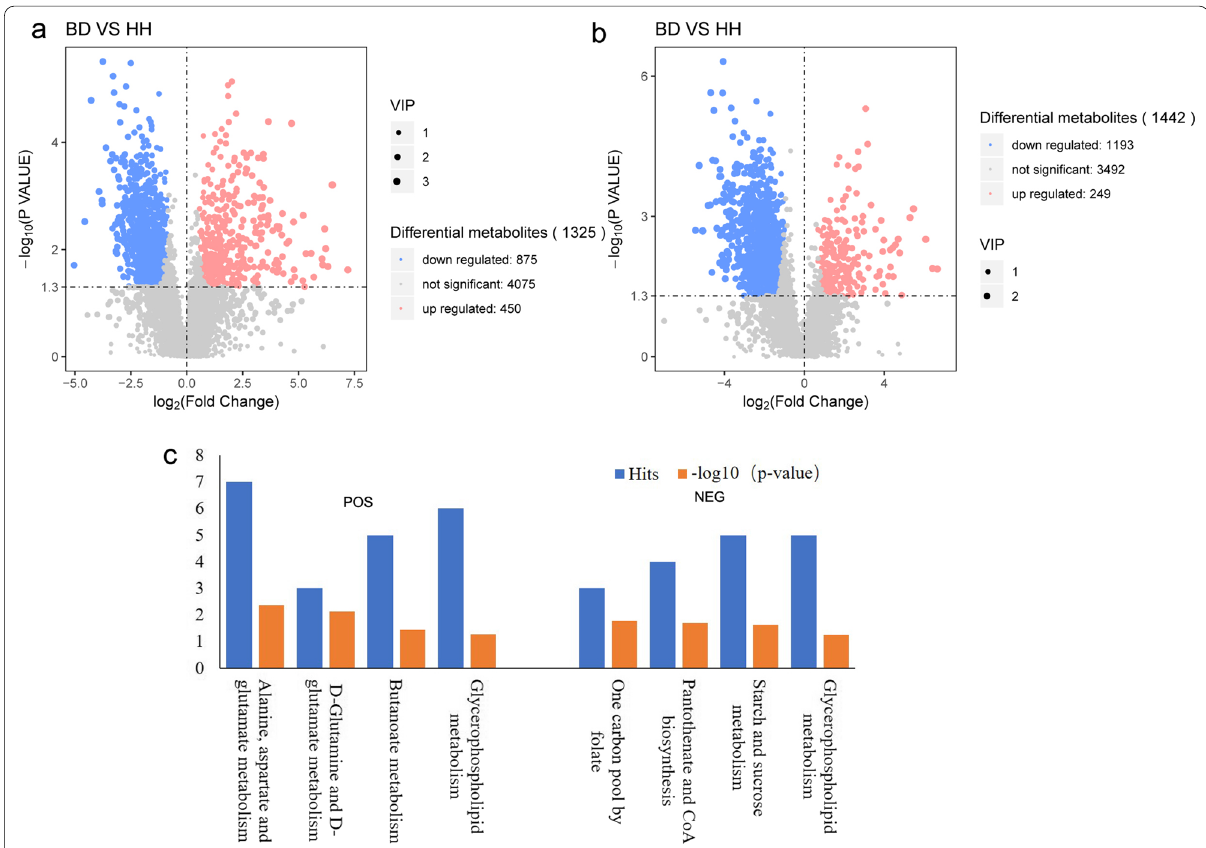
Fig. 2 Scatter plots and KEGG analysis depicting metabolites identified in BD and HH. a Scatter plot of metabolites identified in ESI + mode. b Scatter plot of metabolites identified in ESI − mode. c KEGG analysis of different metabolites in the ESI + and ESI − modes. KEGG Kyoto Encyclopedia of